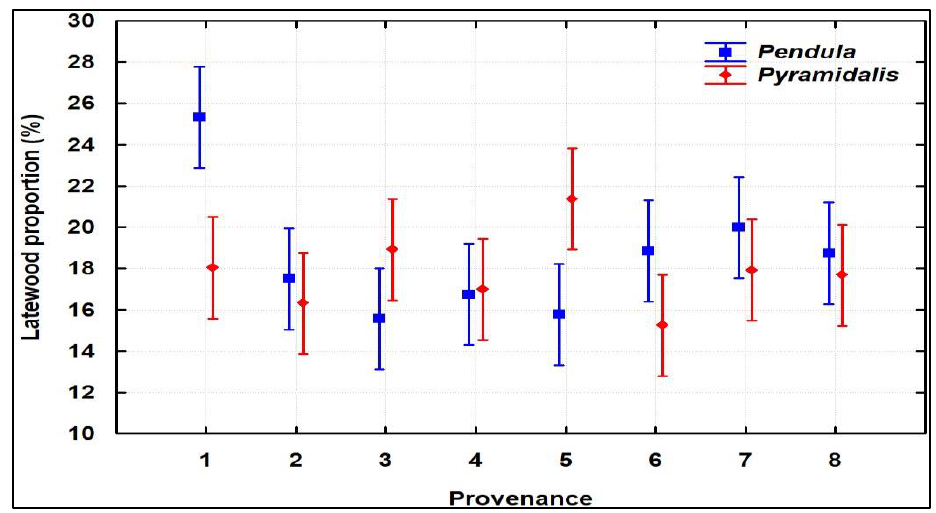
Figure 2. Latewood proportion of the provenances and crown forms (mean ± 0.95 CI).